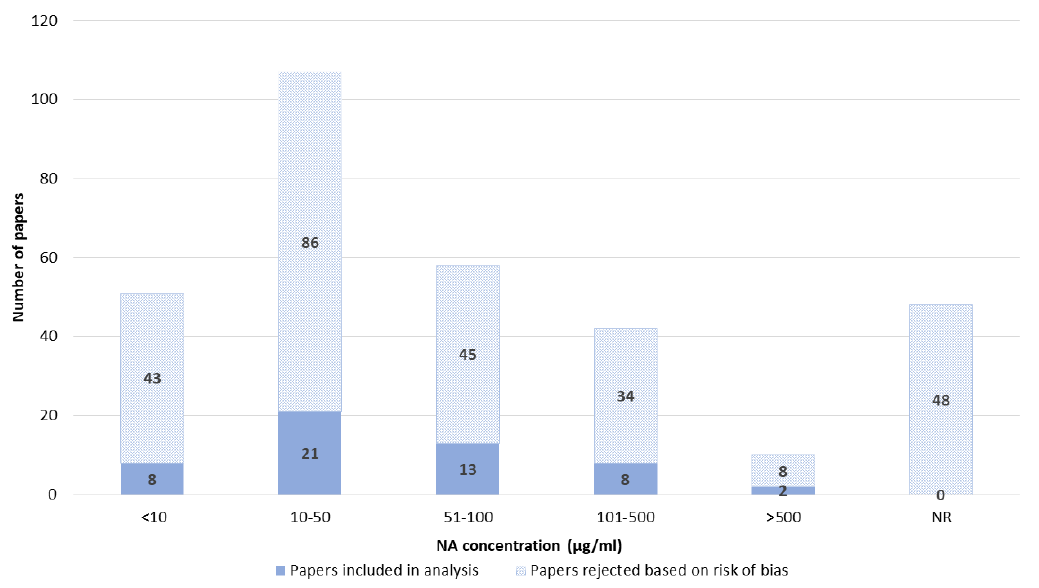
Figure 10. NA concentration. NR—not reported.